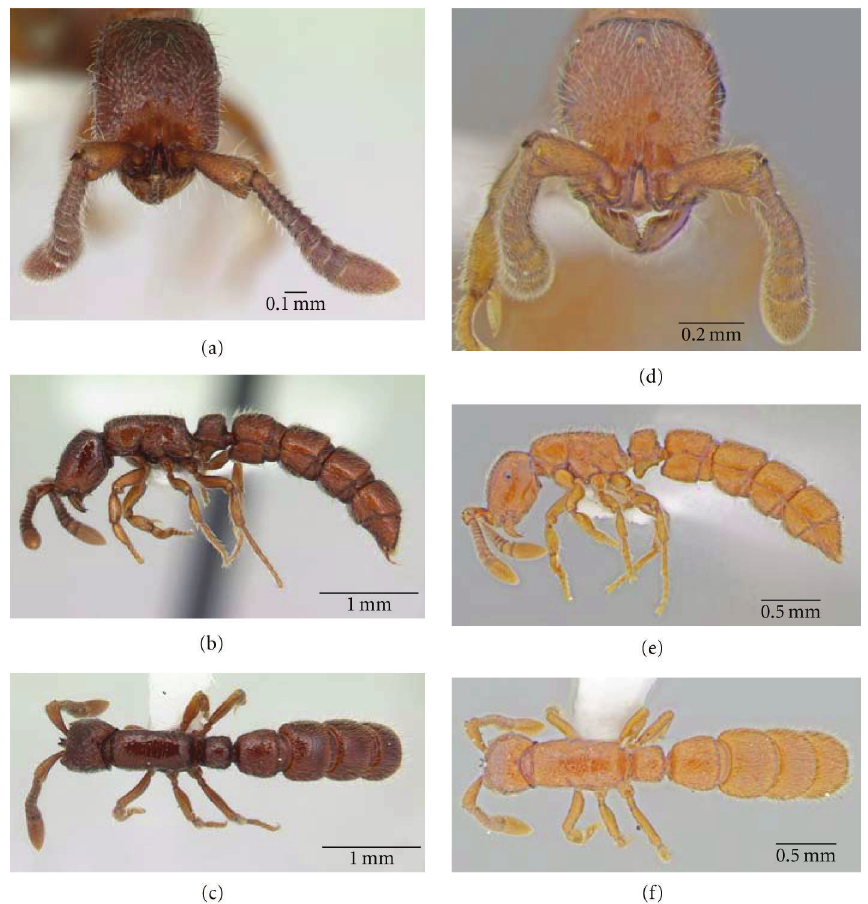
Figure 2: Sphinctomyrmex stali . (a)–(c): worker of morphotype 1 from S˜ao Bonif´acio, SC, Brazil (a) head in full face view, (b) lateral view, (c) dorsal view. Image by Michele Esposito, specimen CASENT 0178866. (d)–(f): ergatoid from S˜ao Bento do Sul, SC, Brazil (d) head in full face view, (e) lateral view, and (f) dorsal view. Image by Ricardo